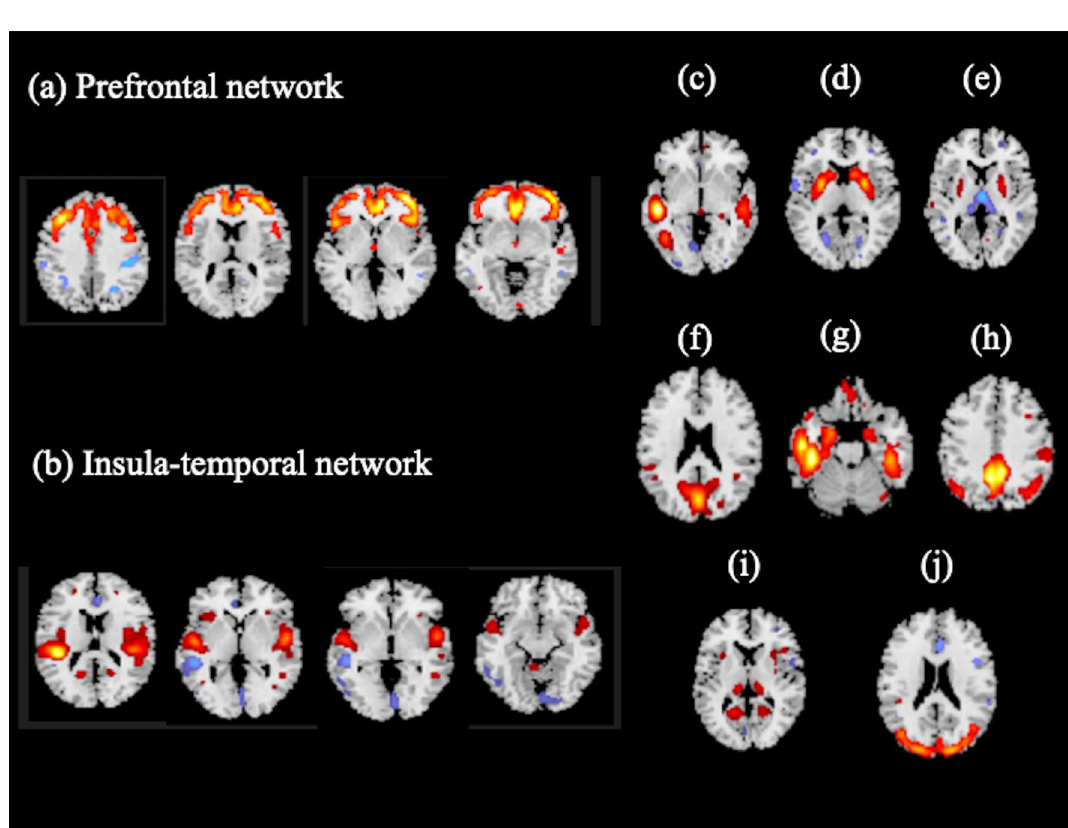
Figure 1. Sources discovered by SBM. Source-based morphometry revealed 10 structural networks. The loading coefficients of the MDD patients in ( a ) the prefrontal network and ( b ) the insula temporal network were significantly lower than those of the healthy subjects (prefrontal network: − 0.25 ± 0.71 and 0.24 ± 0.76, respectively, p < 0.01; insula-temporal network: − 0.27 ± 0.80 and 0.39 ± 0.74, respectively, p < 0.01). ( c ) component 2; ( d ) component 3; ( e ) Component 6; ( f ) Component 9; ( g ) Component 10; ( h ) Component 11; ( i ) Component 12; ( j ) component